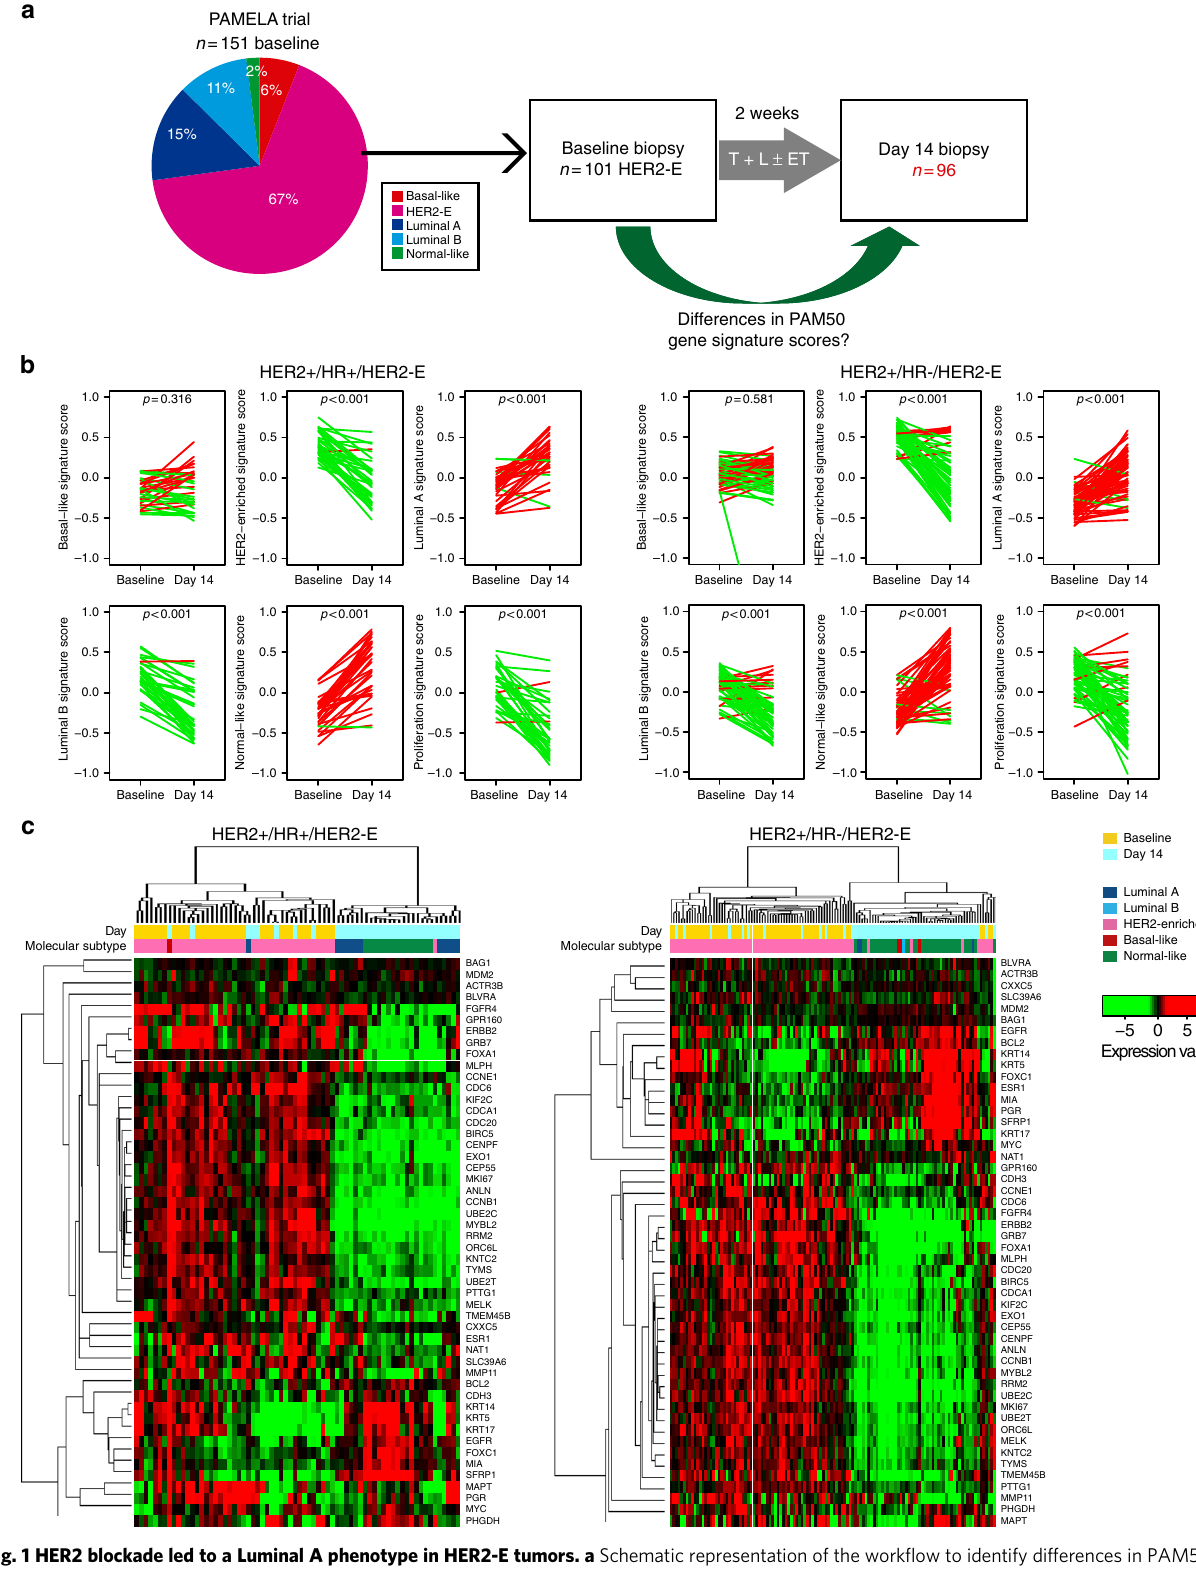
Fig. 1 HER2 blockade led to a Luminal A phenotype in HER2-E tumors. a Schematic representation of the work fl ow to identify differences in PAM50 gene expression signatures in HER2-E tumors ( n = 151) of the PAMELA trial between baseline and day 14 of treatment with lapatinib (L) plus trastuzumab (T) plus endocrine therapy (ET) if HR + . b PAM50 signature scores in HER2 + /HR + /HER2-E at baseline (left) and HER2 + /HR-negative/HER2-E at baseline (right) tumors treated with dual HER2 blockade at baseline and day 14. Each line represents a tumor sample. Increases are represented in red and decreases in green. P -values ( p ) in a and b were determined by two-tailed paired t -tests. c Unsupervised hierarchical clustering across 35 paired HER2 + /HR + /HER2-E at baseline tumors and 61 paired HER2 + /HR-negative/HER2-E at baseline tumors. Heatmaps show high (red) to low (green) expression of mRNAs in each sample. The day of biopsy and molecular subtype calls of each sample are shown. Source data are provided as a Source Data fi